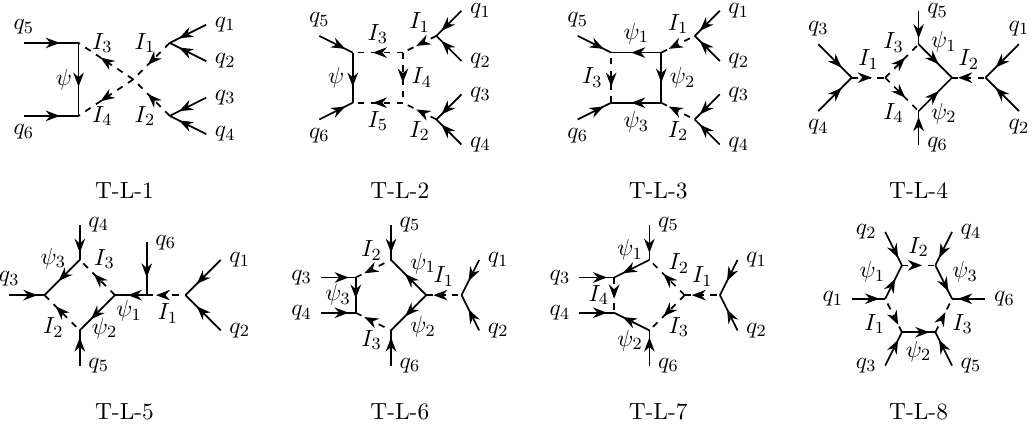
Figure 2 . The genuine diagrams of neutron-antineutron oscillation operator at one-loop